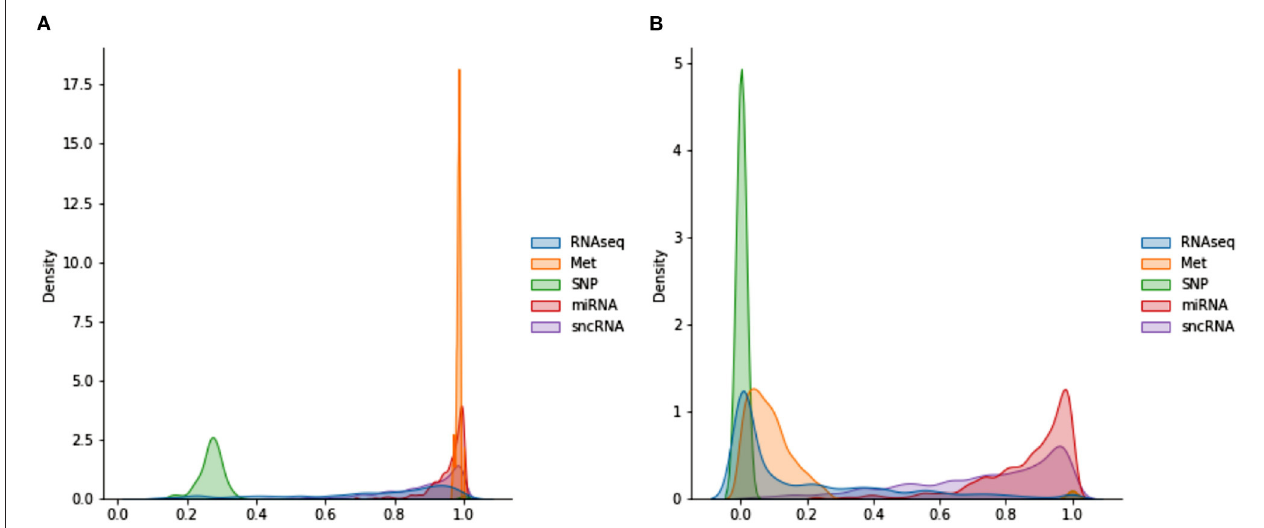
FIGURE 3 | Distributions of POGs used in omics networks (A) before WGCNA (B) after